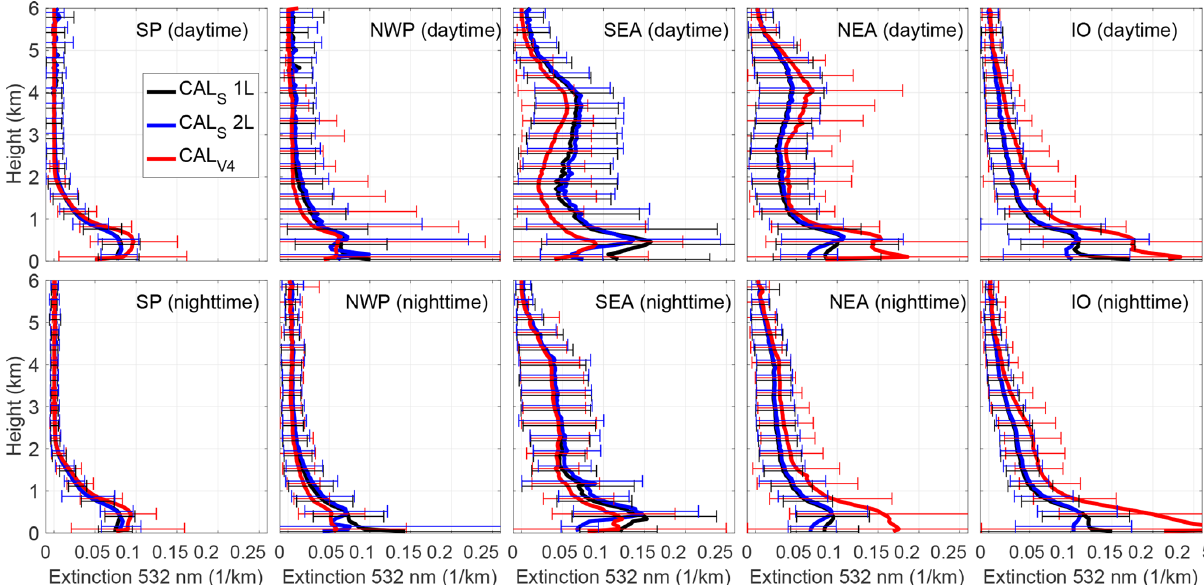
Figure 6. Mean aerosol extinction coefficient at 532nm for the five regions defined in Fig. 4. Upper and lower panels correspond to daytime and nighttime retrievals. CALIPSO–SODA profiles are in black (1L) and blue (2L), and CALIPSO V4 is in red.